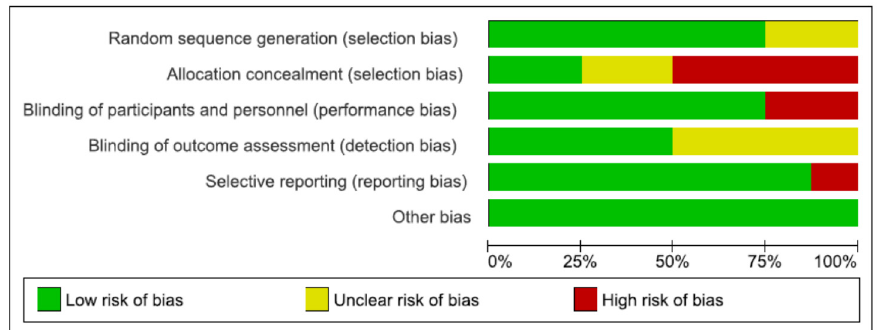
Figure 2. Risk of bias graph of the included studies.